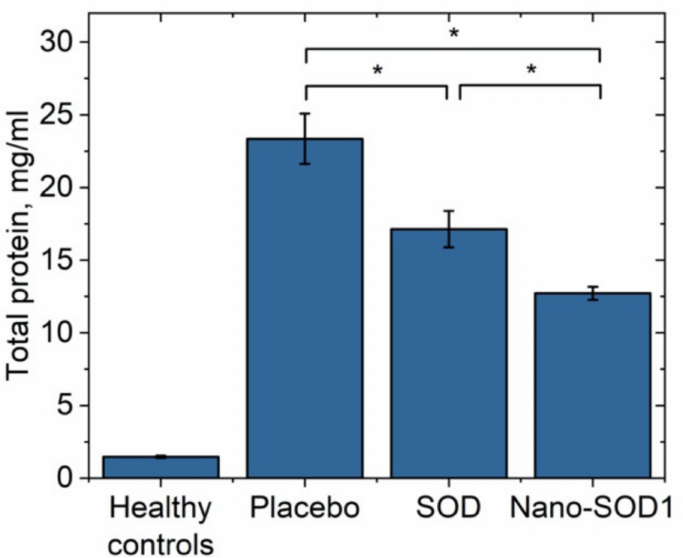
Figure 7. Total protein concentration in the intraocular fluid of rabbits on the 8th day of experimental immunogenic uveitis (mean ± SD) * p < 0.05 (Mann–Whitney U-test). Uveitis was also accompanied by the exhaustion of endogenous antioxidant system of the eye. The AOA in the intraocular fluid on the 8th day of uveitis decreased drastically. In the placebo group, the AOA value was only 76 ± 13 µ M Trolox, while the normal level of AOA was 1100 ± 54 µ M Trolox. Treatment with SOD1 and Nano-SOD1, however, helped to maintain the AOA level, 136 ± 11 µ M Trolox and 270 ± 30 µ M Trolox for SOD1-treated and Nano-SOD1-treated groups, respectively. It is worth noting that Nano-SOD1 was significantly more effective than native enzyme ( p < 0.01) in maintaining protective AOA (Figure 8).